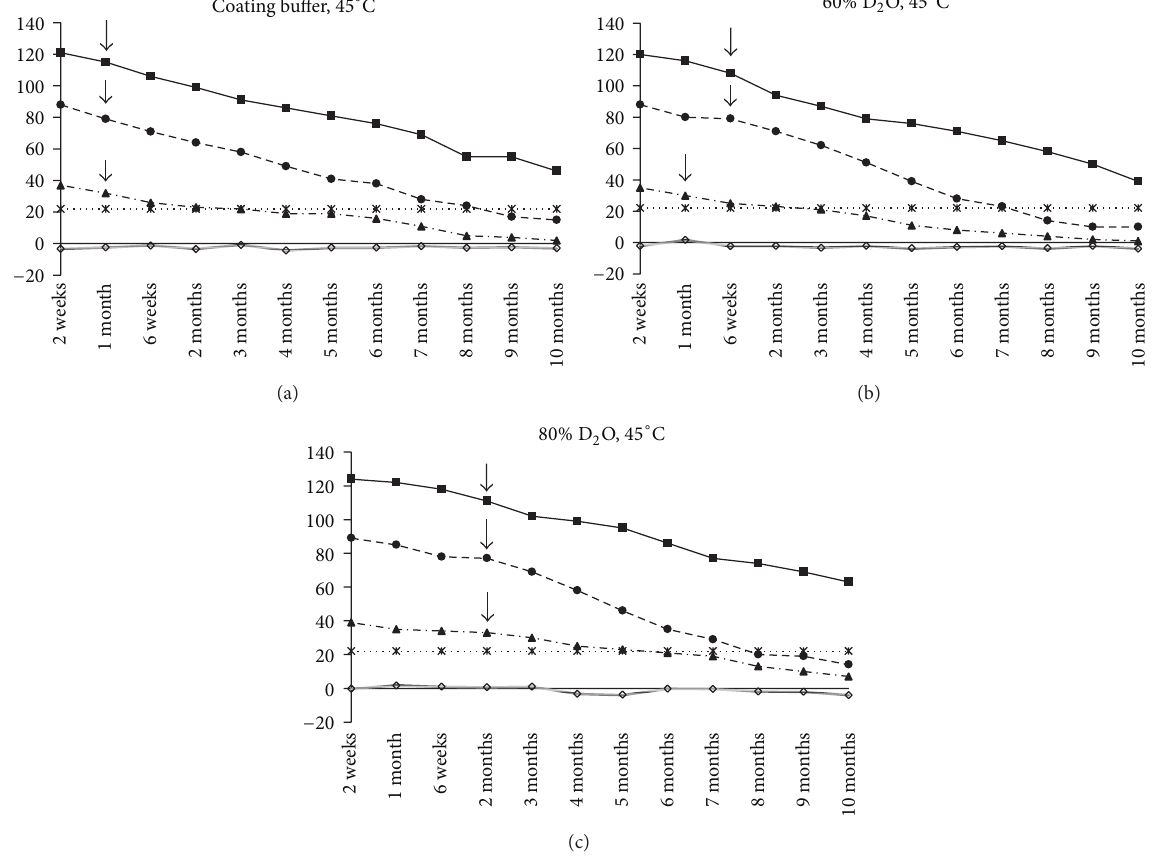
Figure 3: Thermostability of rp26 ELISA at 45 ∘ C. Duration of thermostability is indicated by arrow ( ↓ ) against strong positive serum ( ◼ ), medium positive serum ( e ), and weak positive serum ( 󳵳 ). In 45 ∘ C, significant difference exists in 80% D 2 O versus 60% D 2 O, 𝑃 = 0.01−0.001 , 80% D 2 O versus H 2 O coating buffer, 𝑃 = 0.02 − 0.001 , at 2-month storage with respective serum